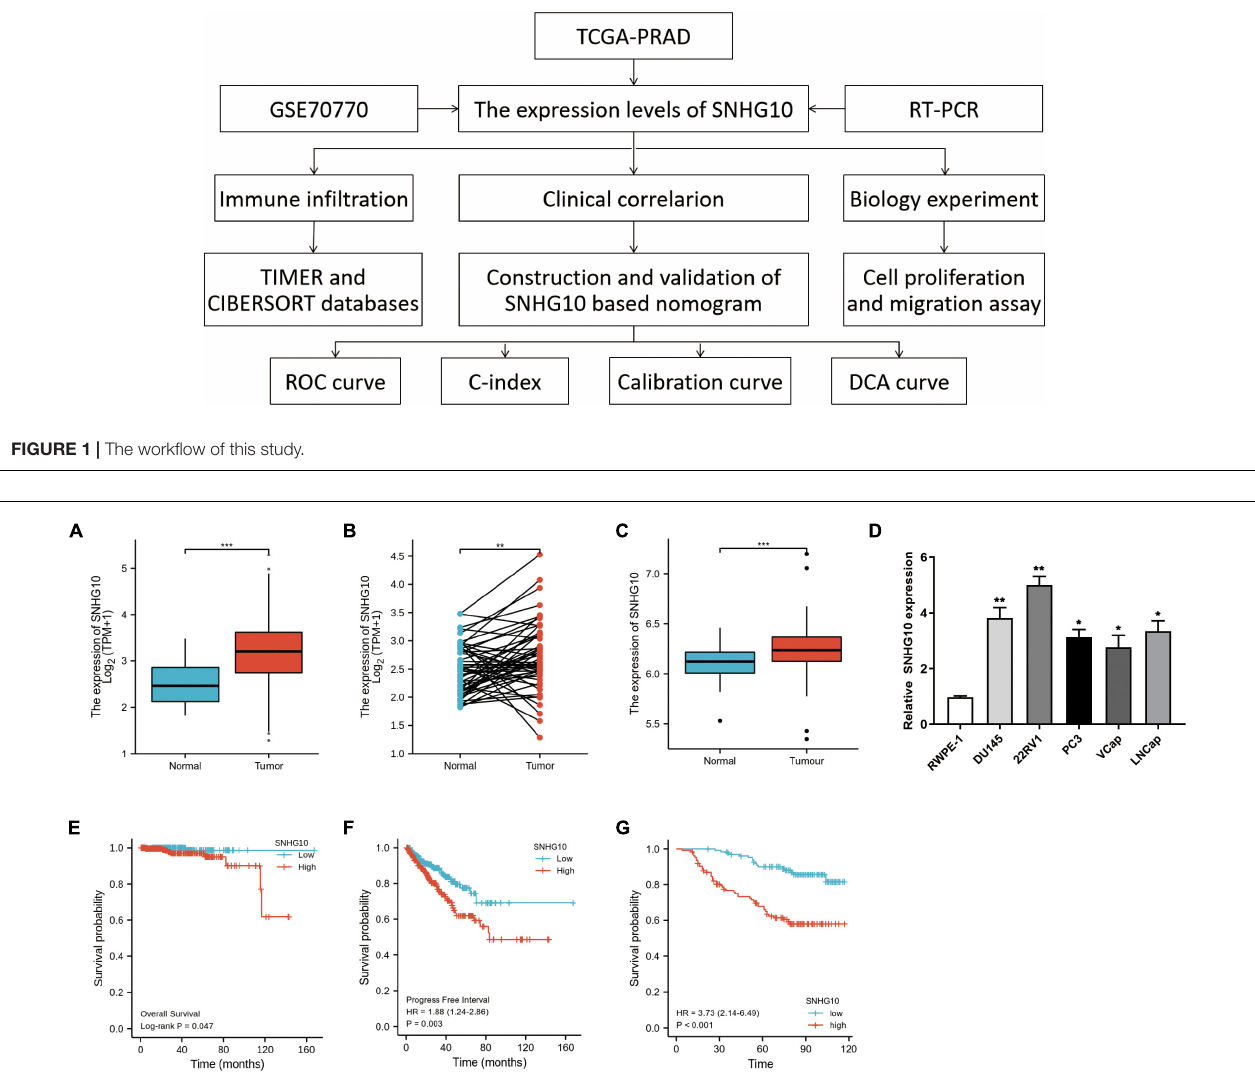
FIGURE 2 | SNHG10 exhibits prognostic value in PC. (A) Comparison of SNHG10 expression between 499 PC tissues and 52 adjacent prostate tissues from TCGA-PRAD. (B) Paired comparison of SNHG10 expression between 52 PC tissues and 52 matching adjacent prostate tissues from TCGA-PRAD. (C) SNHG10 expression between 219 PC tissues and 74 normal tissues in GSE70770. (D) SNHG10 expression was significantly higher in PC cell lines (VCaP, LNCaP, 22RV1, PC3, and DU145) compared with the prostate cell line (RWPE-1). Kaplan-Meier survival analysis was performed to determine differences in (E) OS and (F) PFS between the high-SNHG10 and low-SNHG10 in TCGA-PRAD. (G) Kaplan-Meier analysis in GSE70770. * P < 0.05, ** P < 0.01, and *** P < 0.001.